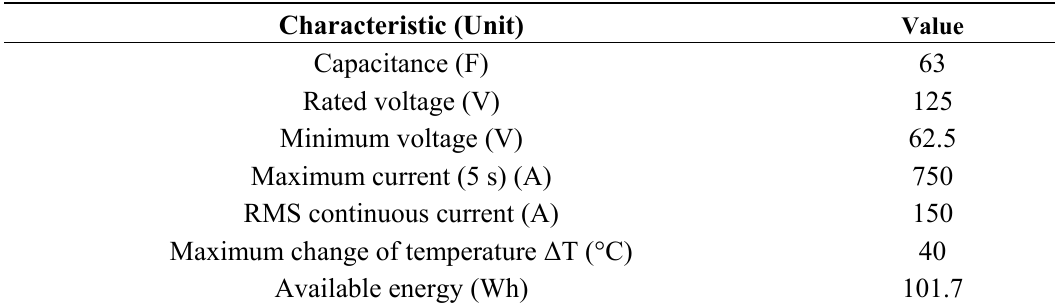
Table 5. Main characteristics of EDLC